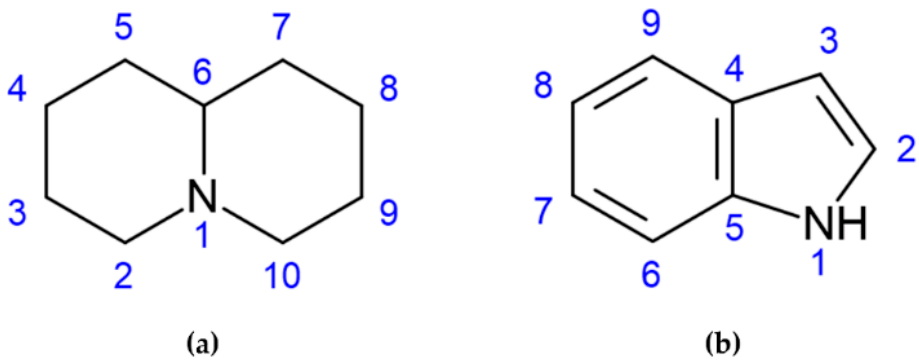
Figure 1. The skeleton structures of ( a ) quinolizidine and ( b ) indole alkaloids are shown. It is possible to distinguish two main types of lupins, sweet and bitter varieties, which differ in the alkaloid content [4]. In the first type, developed by plant breeders, the alkaloid amount ranges between 100 and 800 mg Kg − 1 of dry weight; consumption by humans and animals is allowed [8]. Bitter lupins are characterized by a higher concentration of alkaloids, usually between 5000 and 40,000 mg Kg − 1 of dry weight [9].